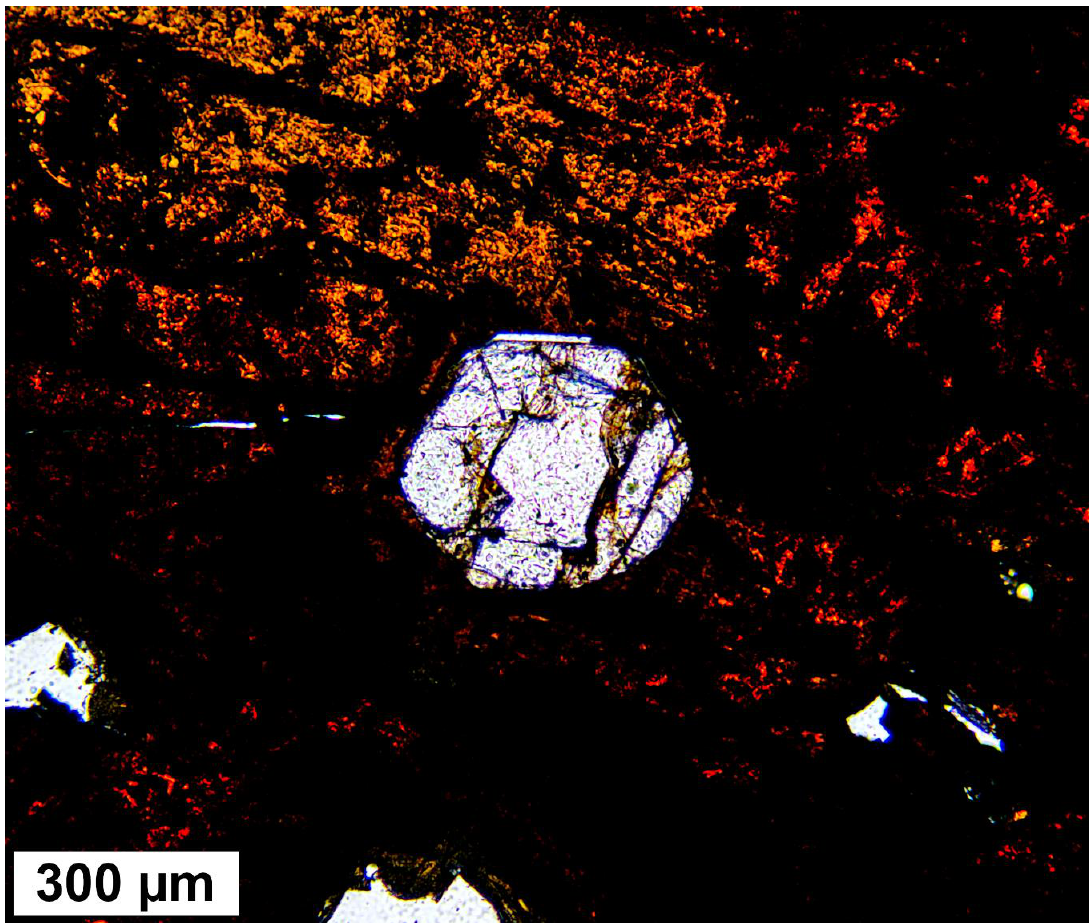
Figure 5. Apatite (bright, center) included within betafite imaged using transmitted plane polarized Figure light.